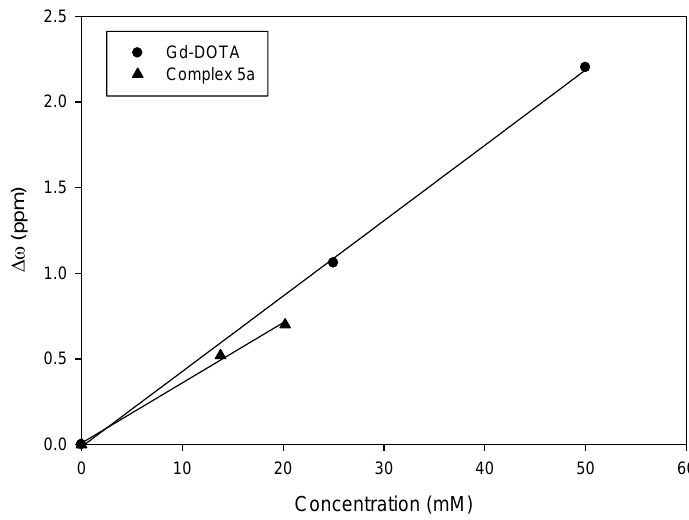
Figure 2. Evolution of the 17 O NMR chemical shift of water with the gadolinium concentration of Gd-DOTA and complex 5a.